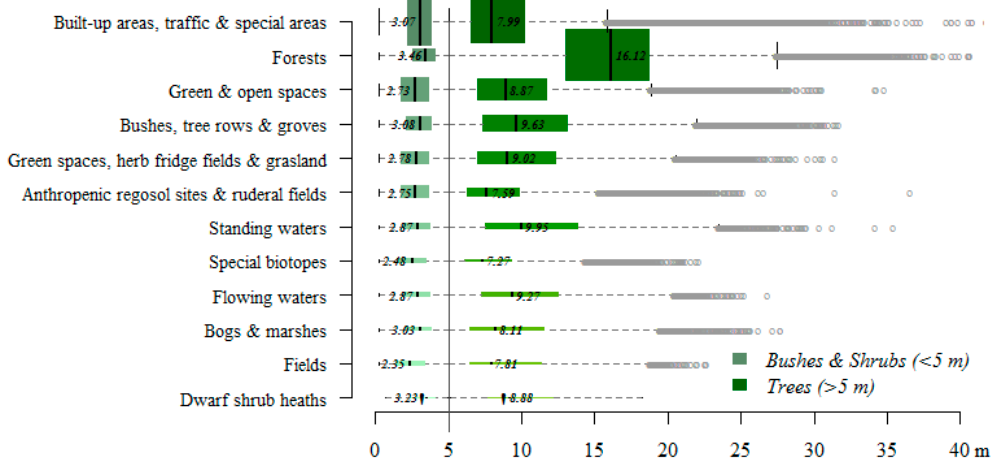
Figure 5. Boxplots of vegetation height distribution for vegetation height classes “Bushes/Shrubs” and “Trees” on 12 biotope classes. The biotope classes are ordered by the weighted area size. The widths of the boxes are drawn proportional to the square-roots of the number of observations (pixels with vegetation) in each biotope class. The outliers for the height class “trees” are indicated by gray circles. The median values are drawn adjacent to the median line.